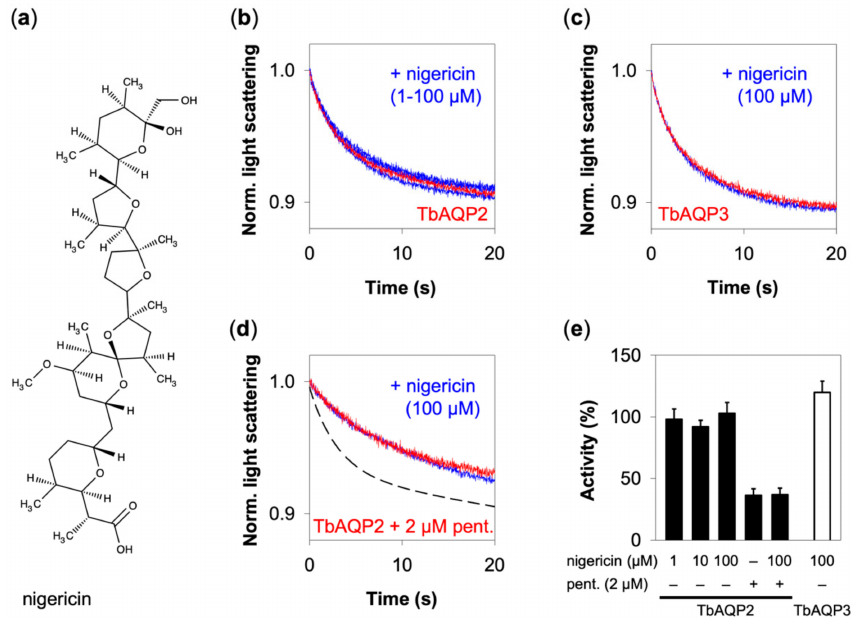
Figure 4. Absence of an e ff ect of nigericin on TbAQP2 and TbAQP3. ( a ) The chemical structure of nigericin. ( b ) Shown are normalized light scattering signals from TbAQP2 glycerol permeability without (red trace) and with preincubation with nigericin (blue traces). ( c ) Normalized light scattering signals from TbAQP3 without (red traces) and with nigericin (blue traces). The curves in ( b , c ) were averaged from 6–9 traces and normalized. ( d ) Normalized light scattering signals from TbAQP2 that was partially inhibited by direct addition of 2 µ M of pentamidine (red trace), or after pretreatment with 100 µ M nigericin (blue trace). The dashed line indicates the position of the uninhibited TbAQP2 signal trace from ( b ). The curves were averaged from 5–8 traces and normalized. ( e ) Relative activity of TbAQP2 and TbAQP3 in the absence and presence of nigericin, with and without co-application of 2 µ M pentamidine. Shown are mean values ± SEM ( n = 2–3). The ethanol concentration for the solubilization of nigericin was kept at 1% in all